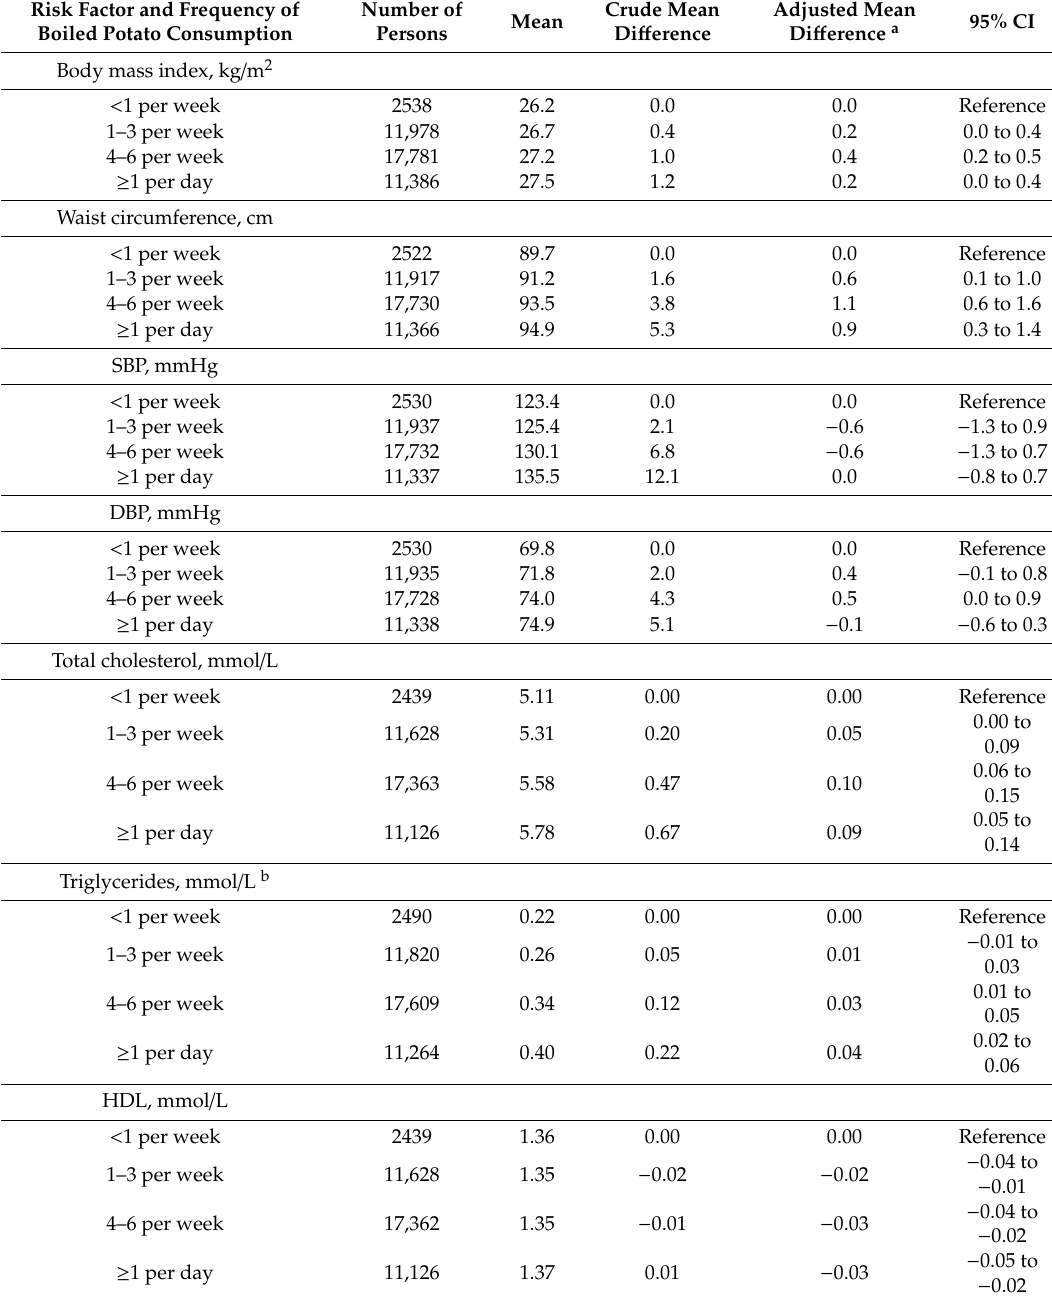
Table 2. Mean di ff erence in components of the metabolic syndrome and cardiovascular disease risk factors according to boiled potato